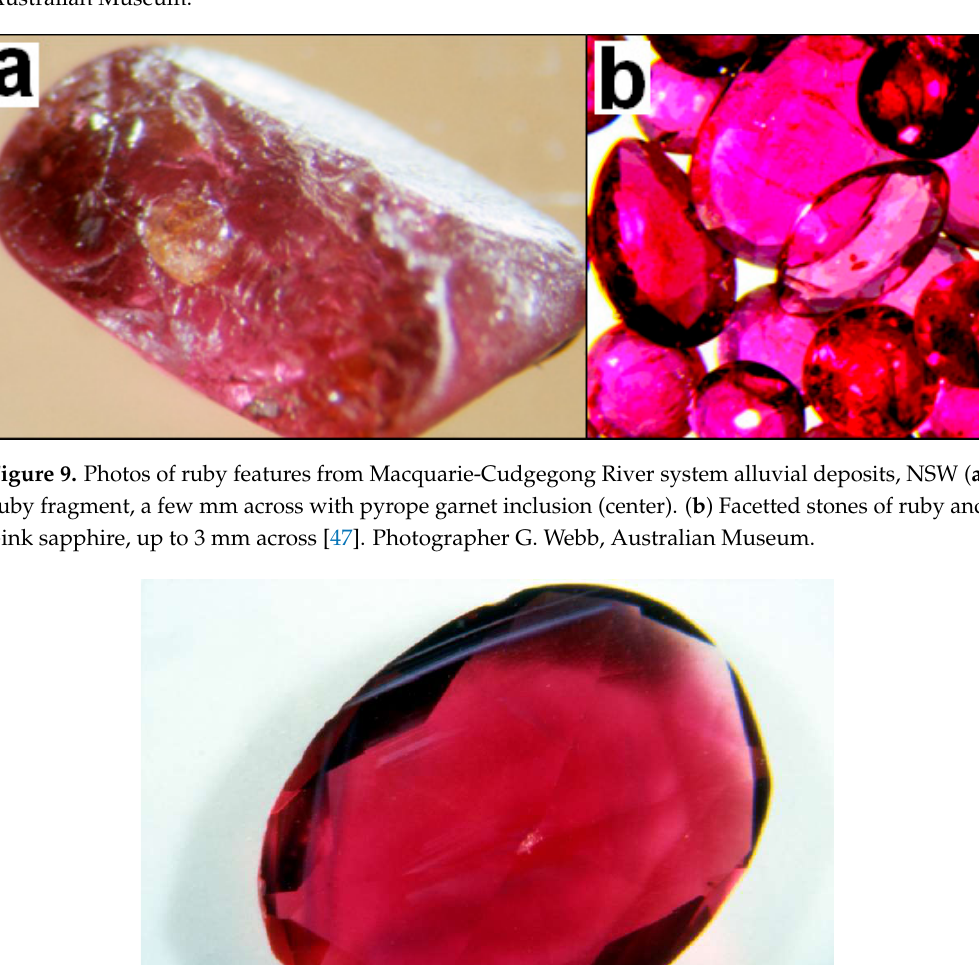
Figure 8. Barrington Tops ruby-sapphirine-spinel composite grain used for thermometric study [42,43]. Sample size ~5 × 7 mm. Ruby main mass (purple red); sapphirine (dark green), center bottom and center right; spinel (black), center left and outer fusion crust. Photographer G. Webb, Australian Museum.